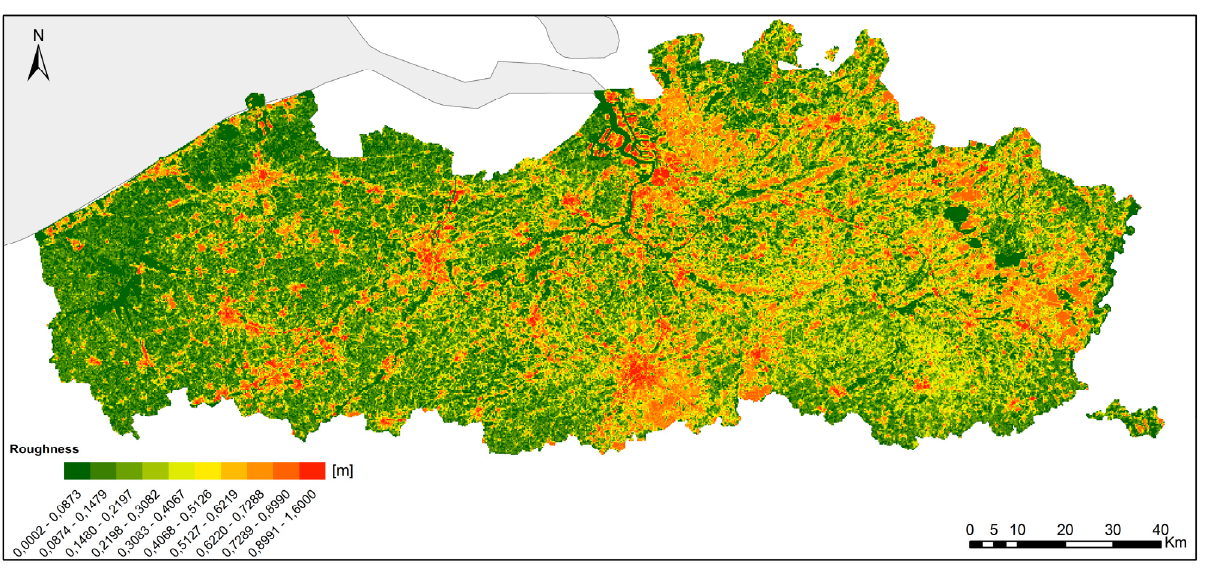
Figure 3. Roughness map of Flanders